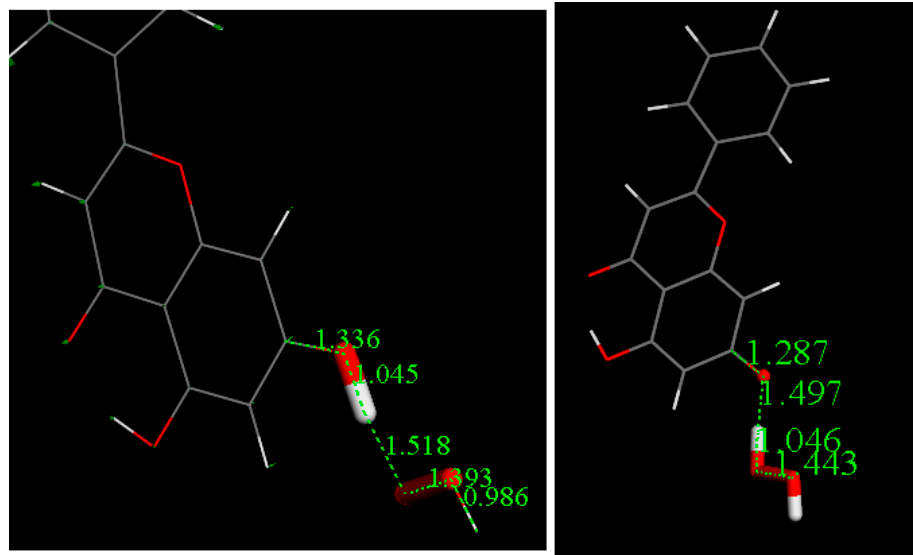
Figure 18. Final Reagent, left, and Product, right, after interaction by a hydronium on the O 2 moiety shown in Figure S2, and after excluding a molecule of water.